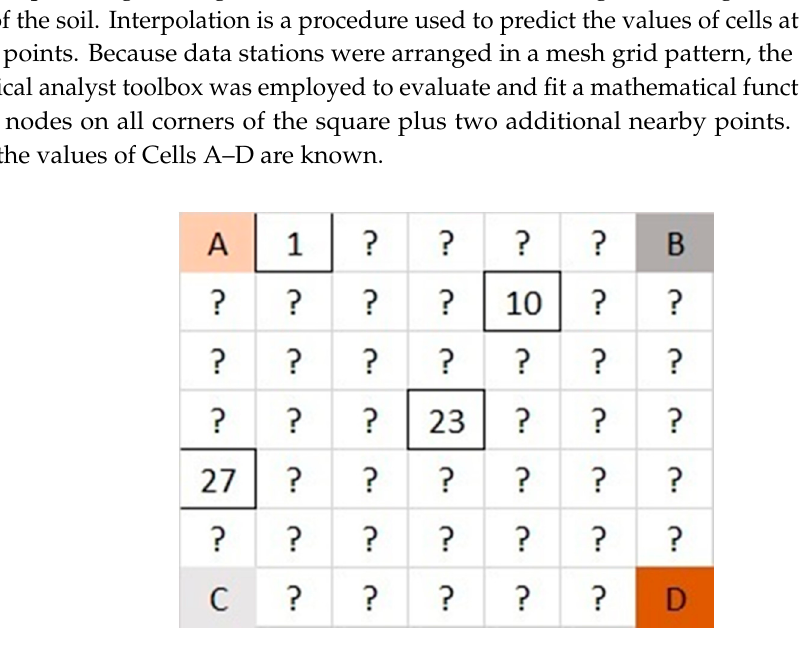
Figure 3. Kriging Analysis Explanation.